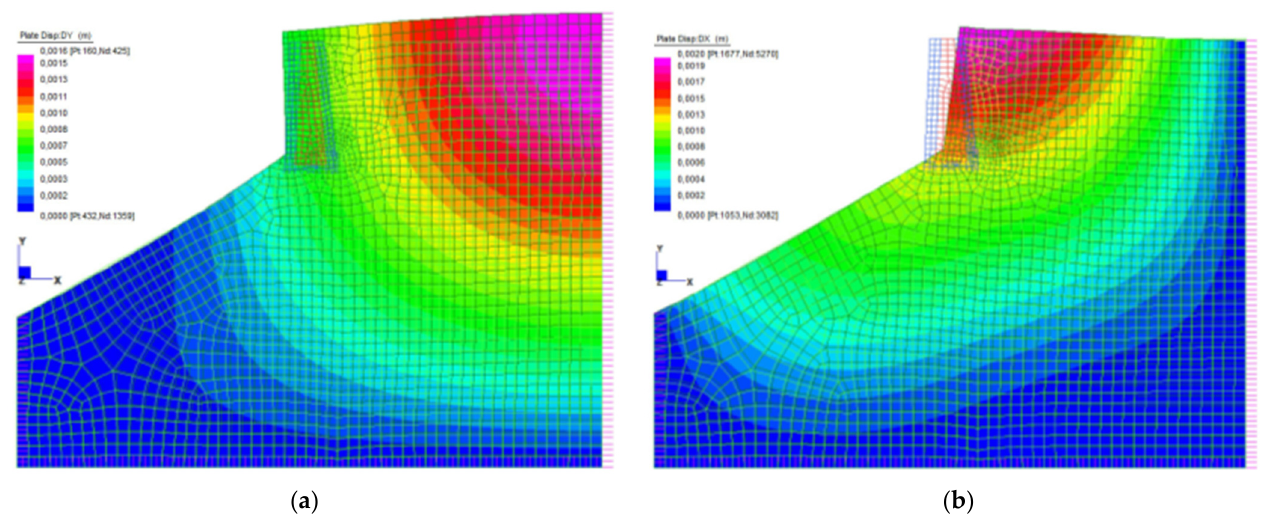
Figure 7. Sections 92–93, ( a ) second mode—participating mass 40.9%; ( b ) first mode—participating Figure 7. mass 54.4%.